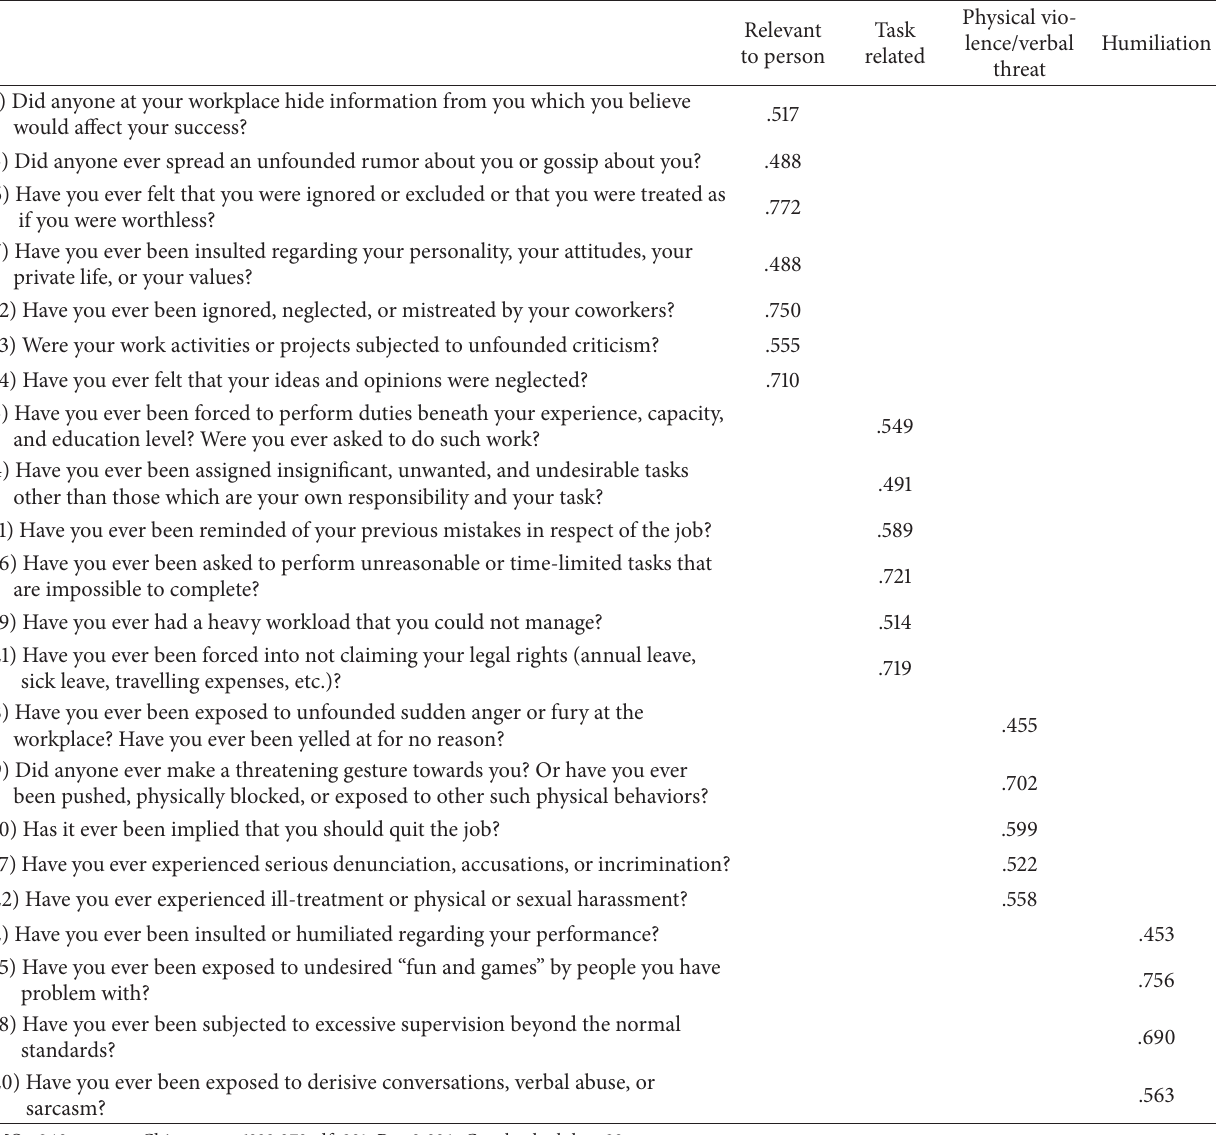
Table 1: Factor analysis for bullying instrument.